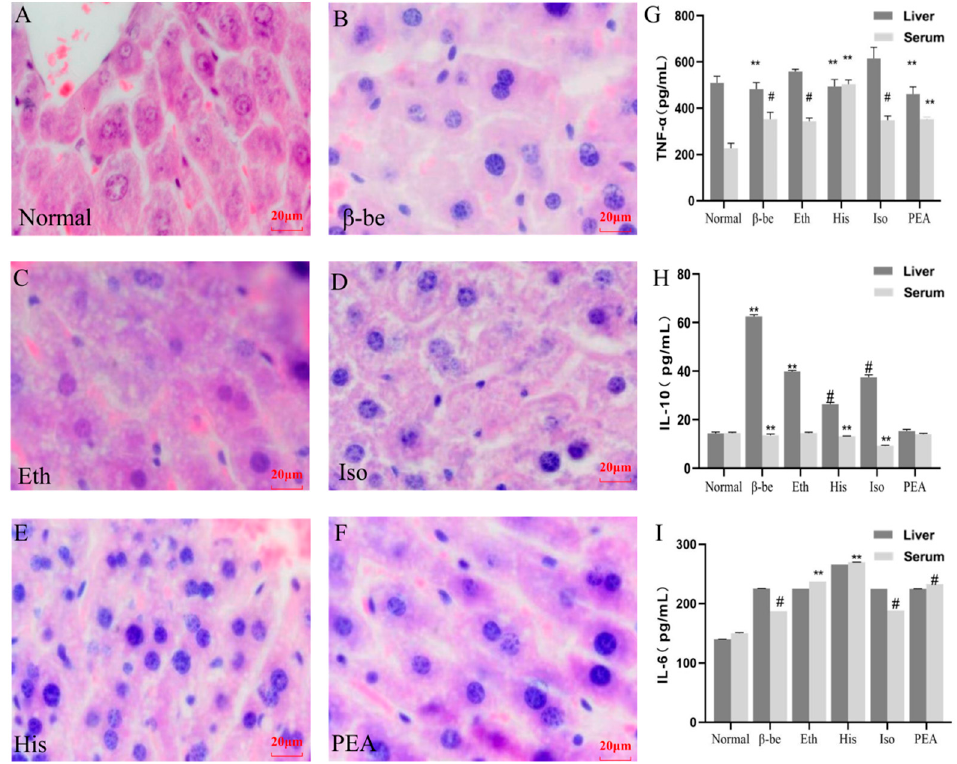
Figure 2. The level of inflammatory cytokines in the liver and serum, and representative histological results using H&E staining. ** p < 0.01; # p < 0.05 vs Normal. ( A ) Representative histological results using H&E in Normal. ( B ) Representative histological results using H&E in β -be. ( C ) Representative histological results using H&E in Eth. ( D ) Representative histological results using H&E in His. ( E ) Representative histological results using H&E in Iso. ( F ) Representative histological results using H&E in PEA. ( G ) Liver and Serum TNF- α . ( H ) Liver and Serum IL-10. ( I ) Liver and Serum IL-6.